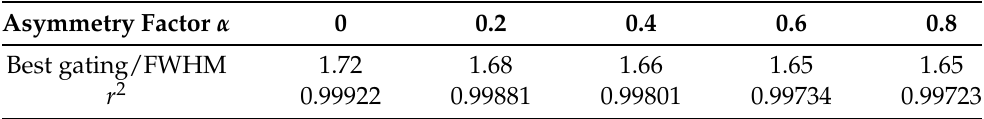
Table 1. Coefficients between pulse length full width half maximum (FWHM) and best gating time for some values of a. The values represent the angular coefficients of the linear regression between the best gating time and the laser pulse width FWHM. To evaluate the goodness of linear fit, the r 2 coefficients are also